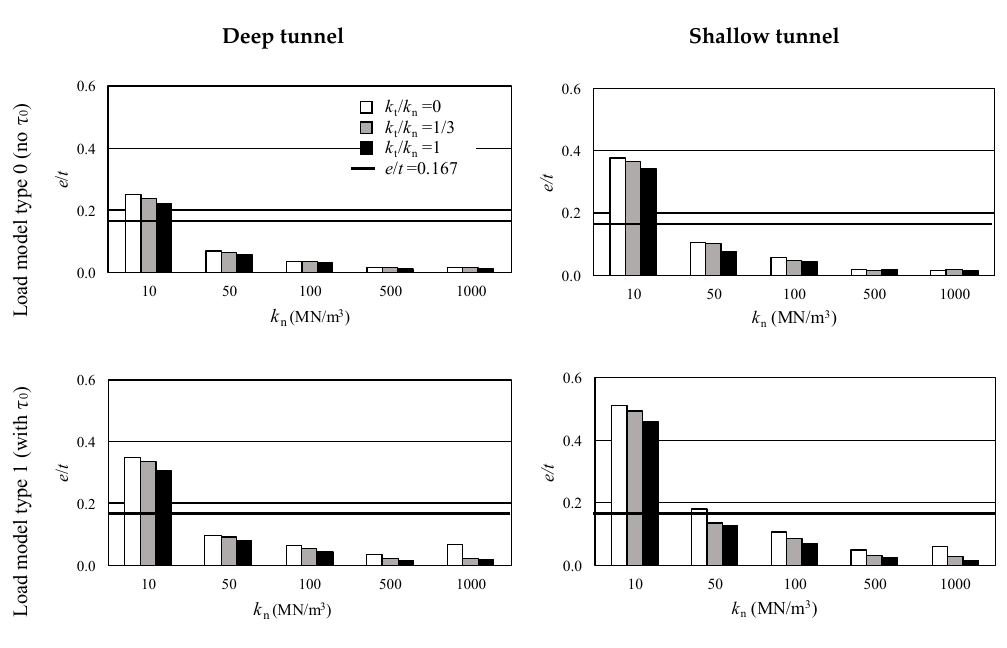
Figure 13. Normalized eccentricity.